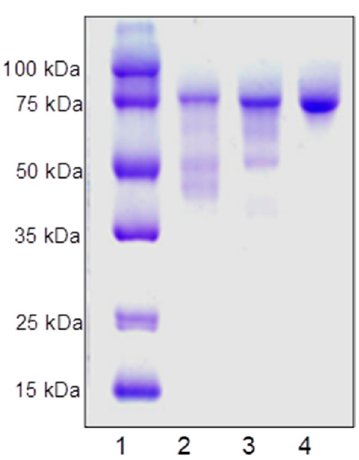
Figure 3. Purification of CGTase from Thermoanaerobacter sp. Lane 1, molecular mass markers; lane 2, crude extract; lane 3, DEAE chromatography step; and lane 4, affinity chromatography step.